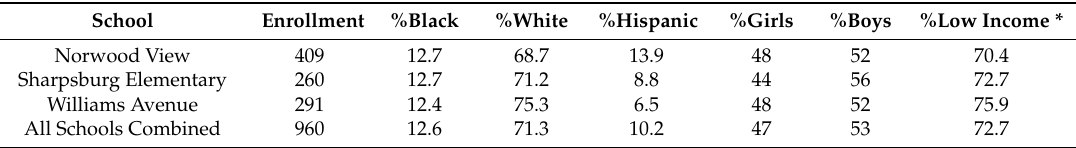
Table 1. Demographics of schools participating in